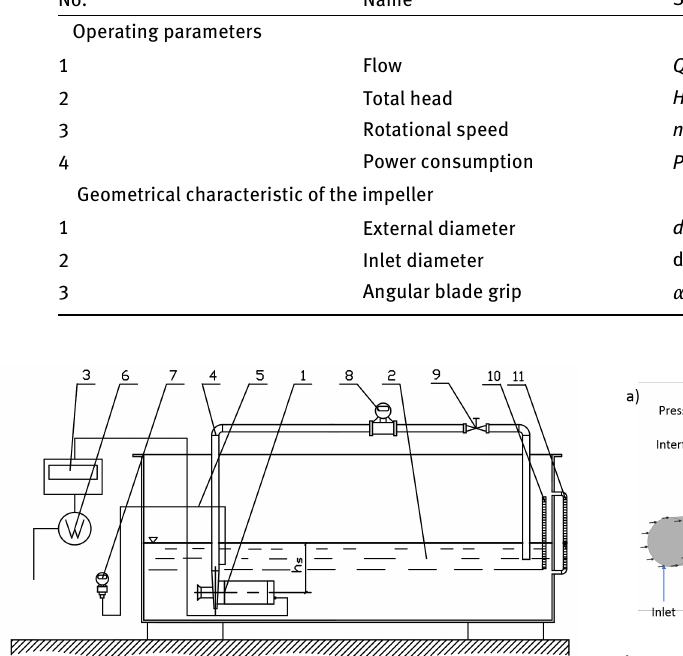
Table 1: Operating and geometrical parameters of the analyzed single-blade pump No.